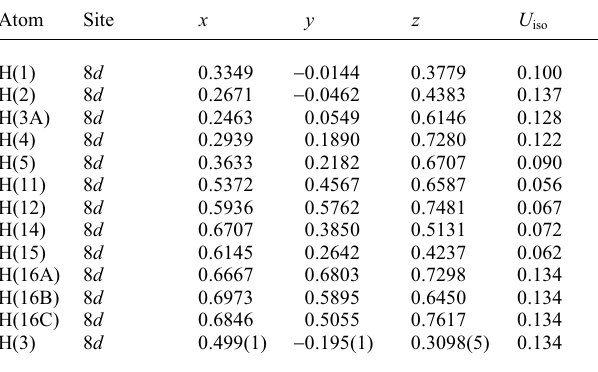
Table 2. Atomic coordinates and displacement parameters (in Å 2 )